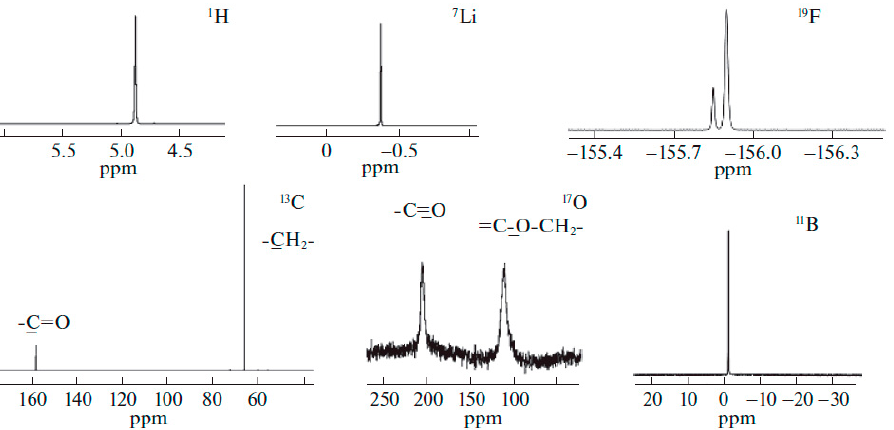
Figure 5. Experimental 1 H, 7 Li, 19 F, 13 C, 17 O, and 11 B NMR spectra of a 0.66 molality solution of LiBF 4 in ethylene carbonate [121]. Membranes 2022 , 12 , x 11 of 42